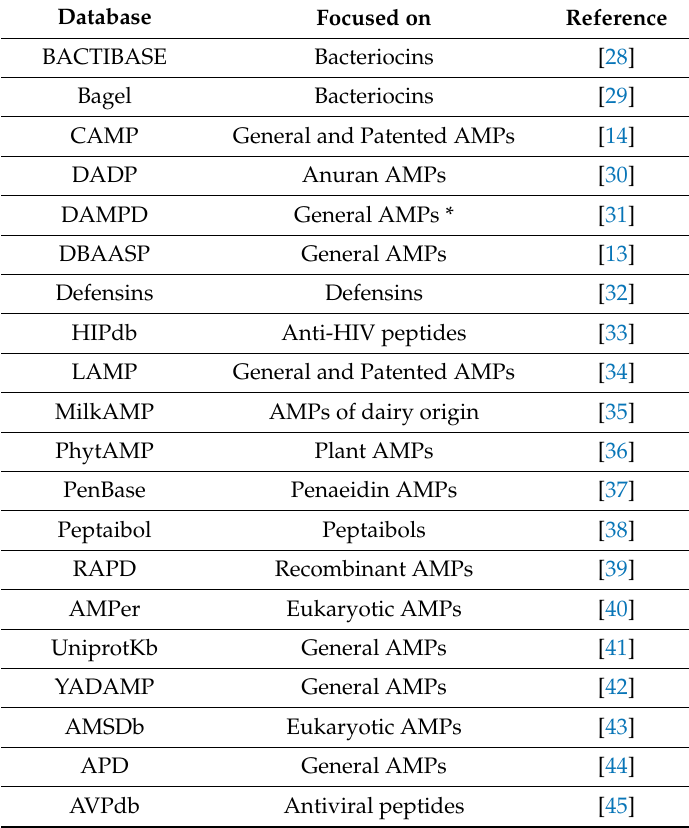
Table 5. Antimicrobial peptide databases used in the present